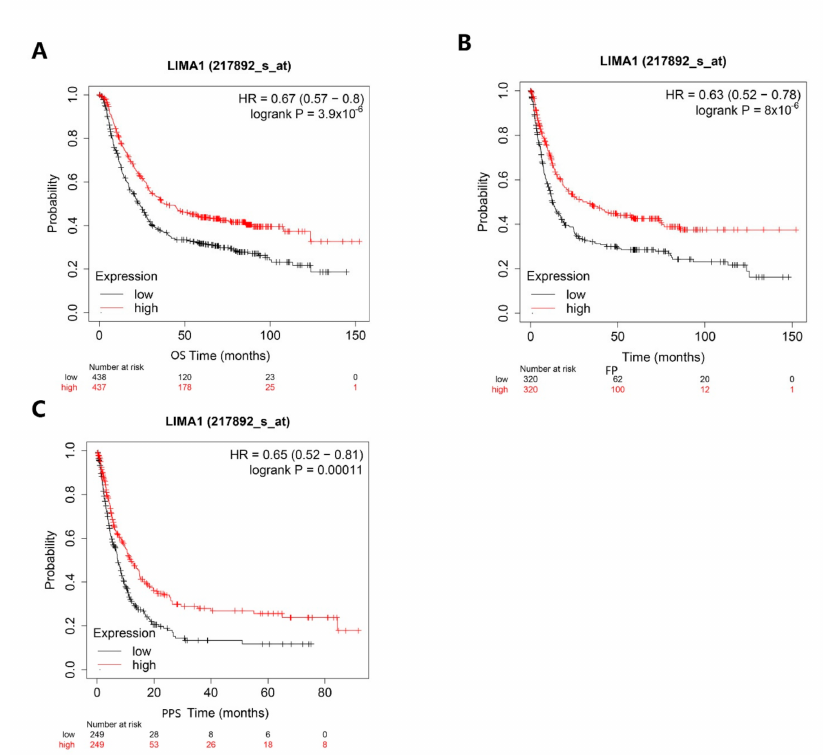
Figure 3. Analysis of LIMA1/EPLIN association with gastric cancer survival in online database. ( A ): Patients with high LIMA1 expression had a significantly longer overall survival (OS) than those with low LIMA1 expression. ( B ): Patients with high LIMA1 expression had a significantly longer first progression (FP) survival time than those with low LIMA1 expression. ( C ): Patients with high LIMA1 expression had a significantly prolonged PPS compared to those with low LIMA1 expression. Images produced and obtained using Kaplan-Meier Plotter website